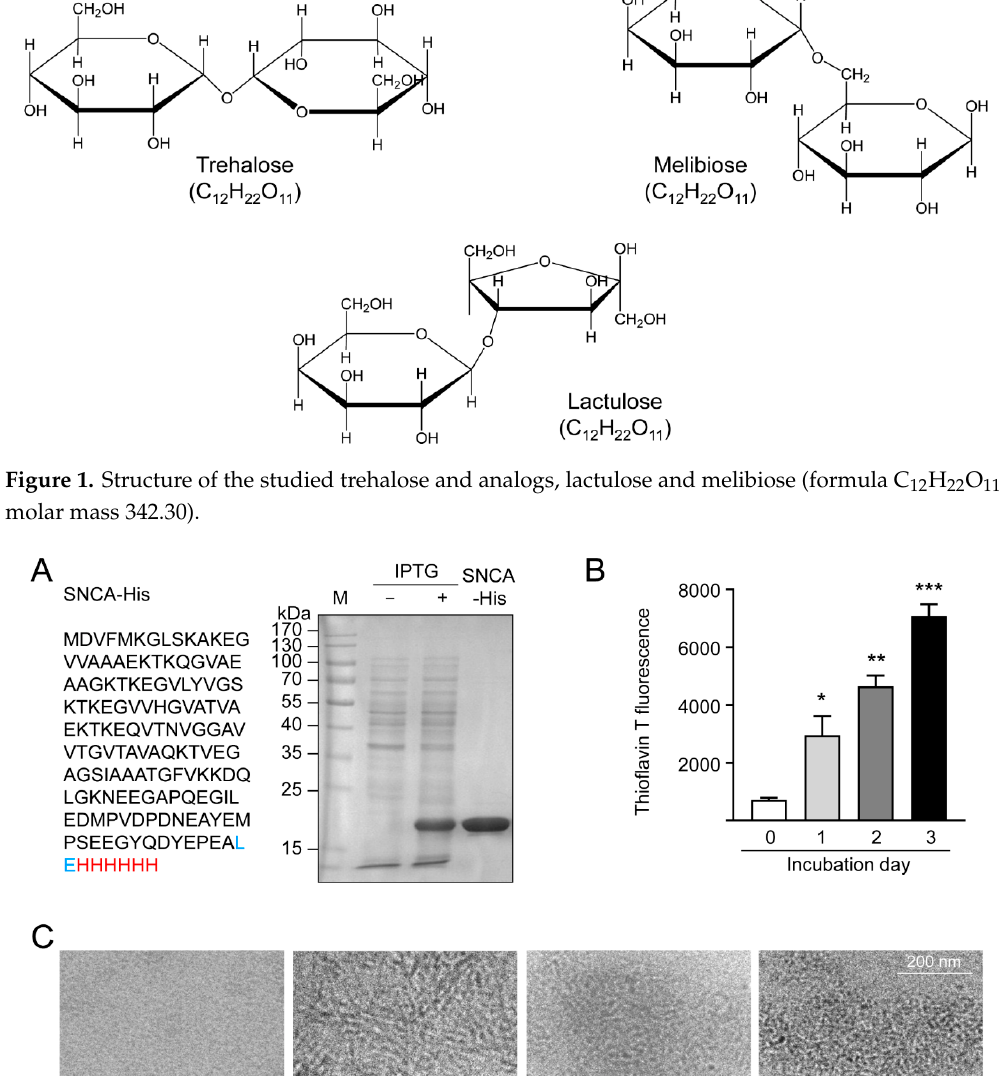
Figure 2. SNCA-His protein and α -synuclein aggregation examined by thioflavin T fluorescence, SDS- PAGE/immunoblot, filter trap assay, and cryo-TEM. ( A ) SNCA-His protein and IPTG-induced expression in E. coli BL21(DE3). α -Synuclein (140 amino acids, marked in black) was fused in-frame to a 6-amino acid His tag (marked in red) via a 2 amino-acid linker (marked in blue). Bacterial cell lysates added with or without IPTG and affinity resins-purified protein were examined by Coomassie